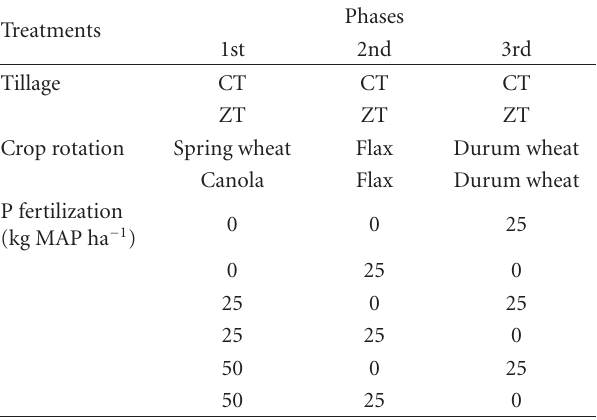
Table 2: Description of the experimental design in the